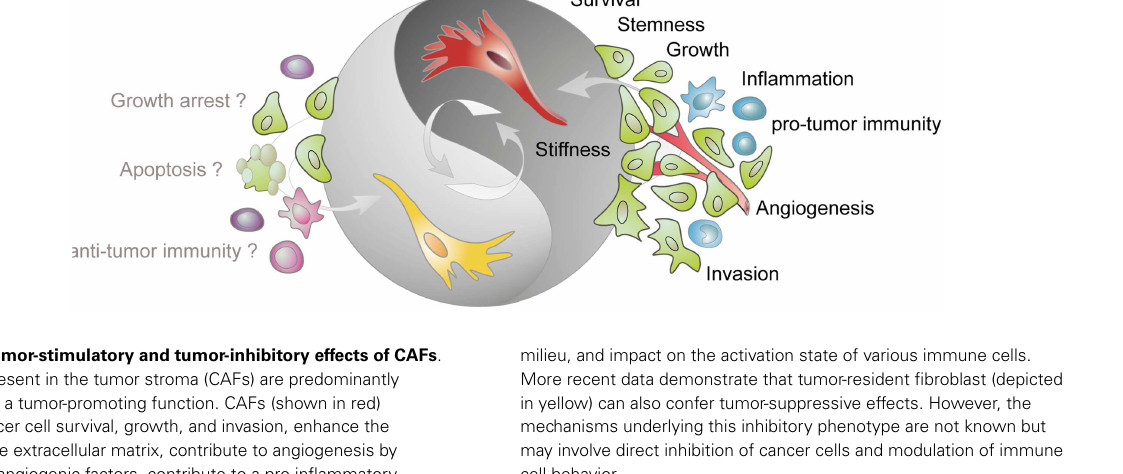
FIGURE 1 |Tumor-stimulatory and tumor-inhibitory effects of CAFs . Fibroblasts present in the tumor stroma (CAFs) are predominantly assigned with a tumor-promoting function. CAFs (shown in red) stimulate cancer cell survival, growth, and invasion, enhance the stiffness of the extracellular matrix, contribute to angiogenesis by releasing pro-angiogenic factors, contribute to a pro-inflammatory